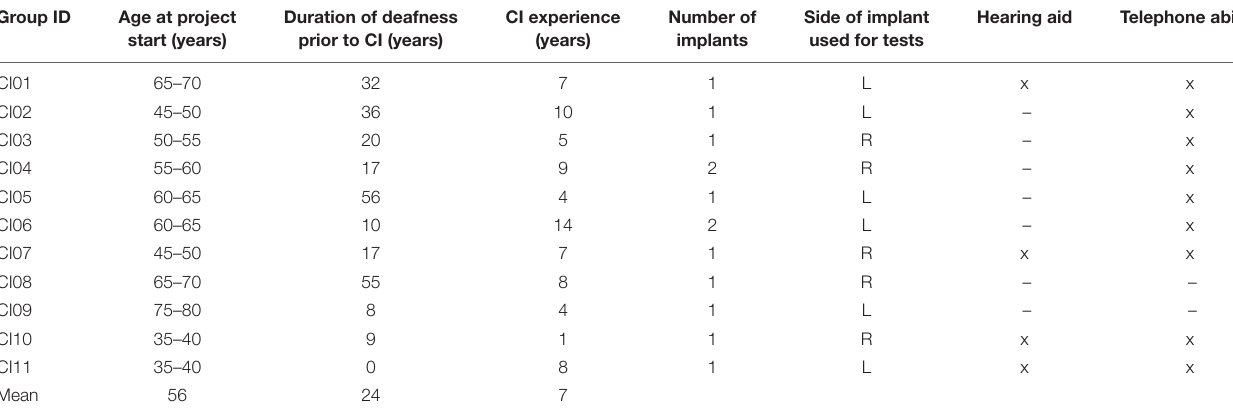
TABLE 1 | Demographic and clinical characteristics of the 11 CI